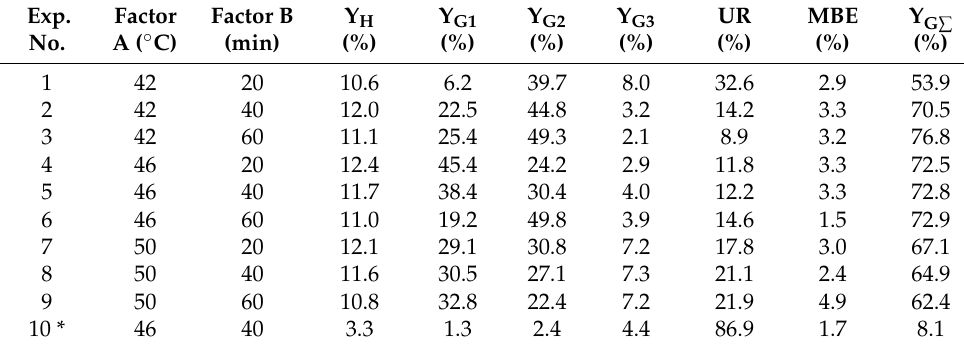
Table 1. The experimental design and the results of the process mass balance. Exp. No.